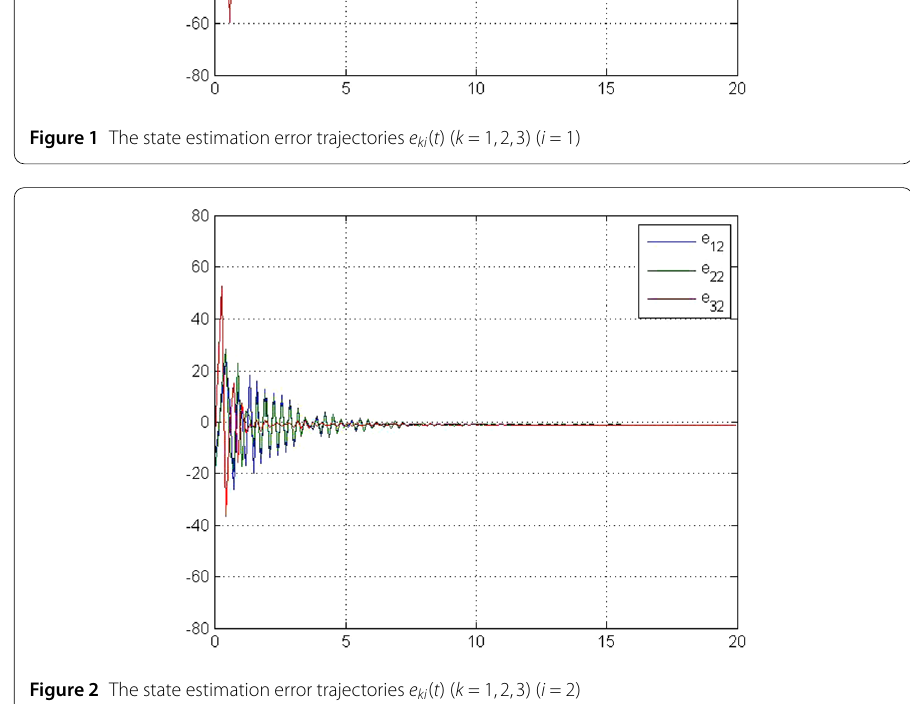
Figure 2 The state estimation error trajectories e ki ( t ) ( k = 1,2,3) ( i = 2)